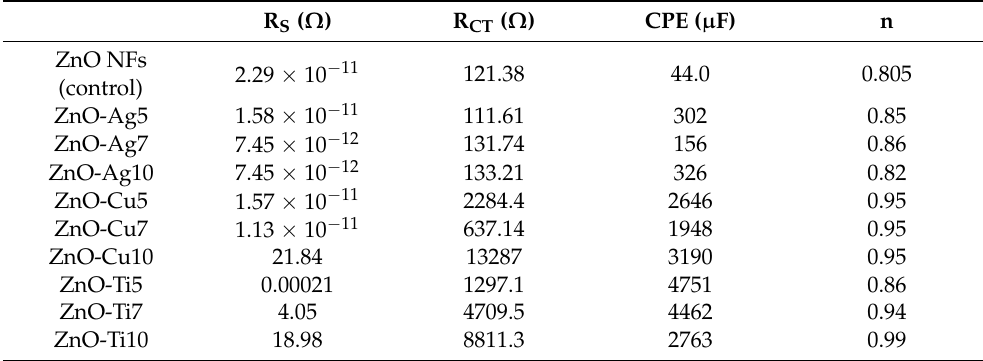
Table 2. EIS raw and fitted curve parameters for ZnO (Ag, Cu, and